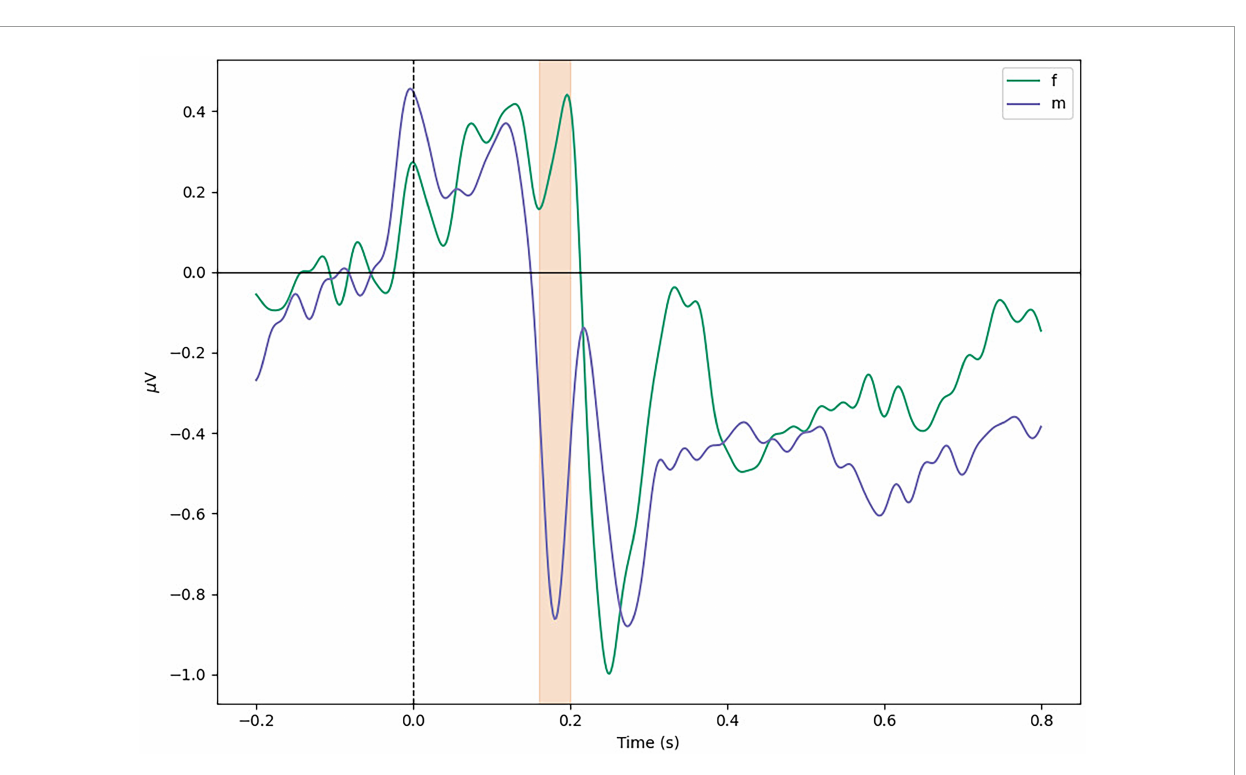
FIGURE6 Average difference between sexes in temporal left ROI. Marked window is 160–200